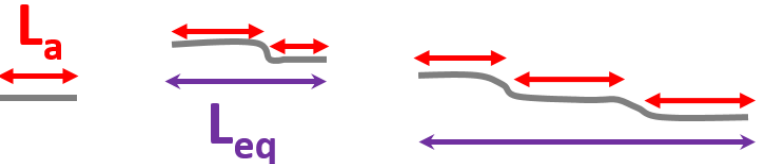
Figure 19. Tortuosity as defined by Larouche et al. [249]. The domains represented by red arrows ( L a ) are aromatic domains without defects. The domains represented by purple arrows ( L eq ) are composed of several aromatic domains, in ‐ between there are curved graphene sites.